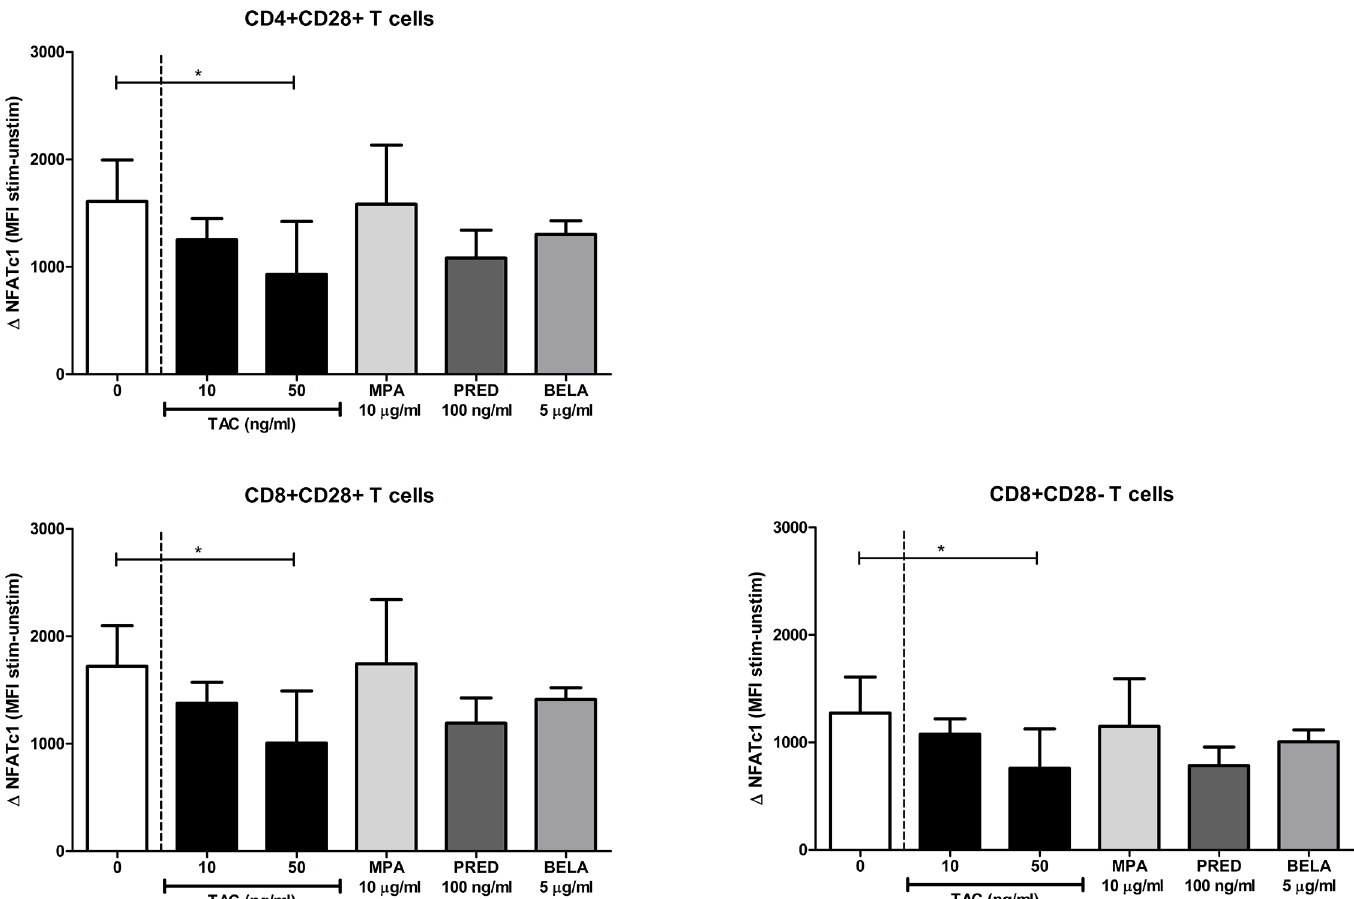
Fig 6. Individual drug effects on NFATc1 amplification in T cell subsets. TAC, at a high concentration of 50 ng/ml, significantly inhibited the expression of NFATc1 in both CD4 + CD28 + ( upper graph ), CD8 + CD28 + ( lower left graph ) and CD8 + CD28 - cells ( lower right graph ) compared to the sample without drugs. Data are plotted as mean ± SEM; n = 5; (cid:3) ) p <